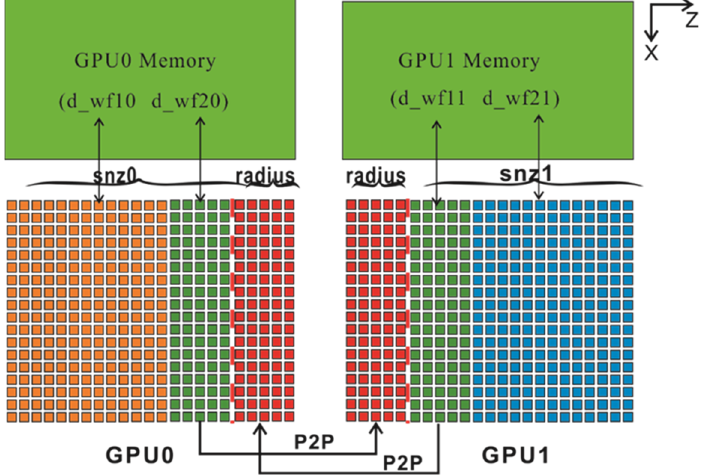
Figure 7. Memory management methods for the calculation of partitioned imaging spaces in two GPUs.